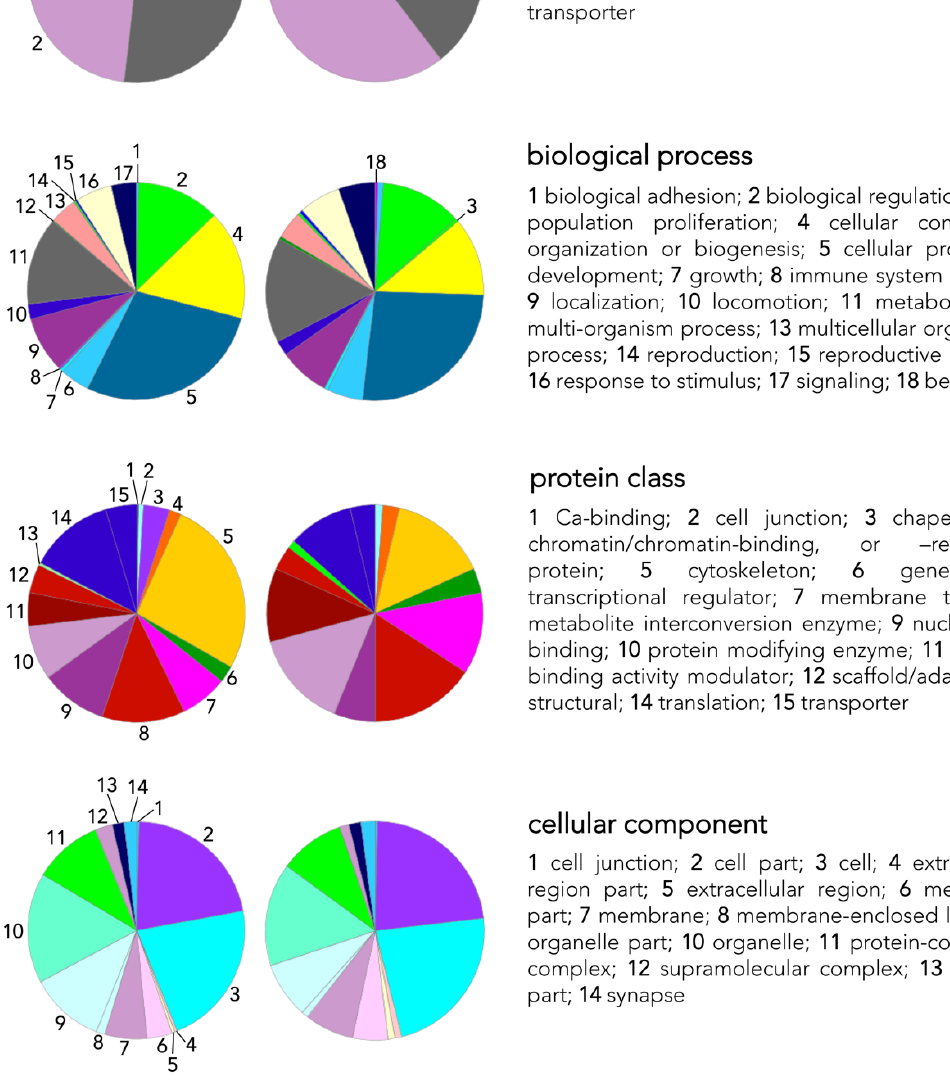
Figure 3. Classes and categorization of proteins in the DAPK1 interactome. Panther™ v15.0 (pantherdb.org) was used to classify proteins of the DAPK1 interactome in control neurons and those interactors found increased in OGD-exposed neurons (they are shown in a pie chart on the left). Four main classes are defined, each encompassing a number of different categories encoded by colors and explained on the right side of each class.